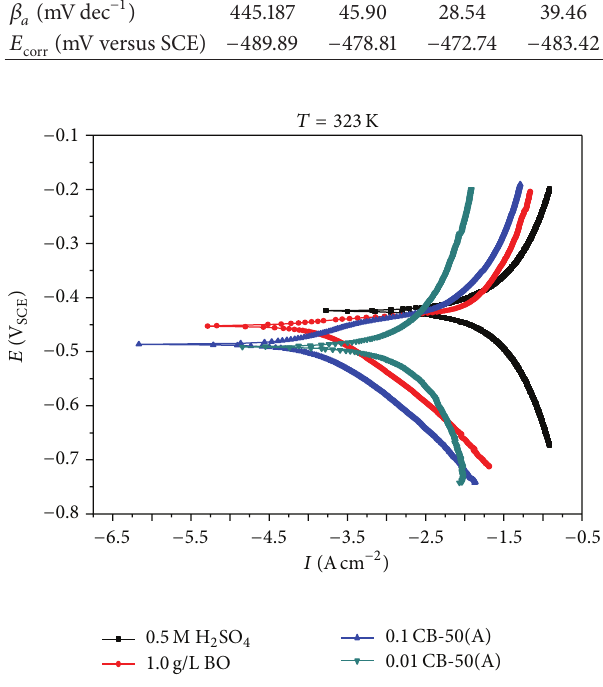
Figure 3: Potentiodynamic polarization curve for pipeline steel in 0.5 M sulfuric acid with and without different concentrations of Brassica oleracea extract at 323